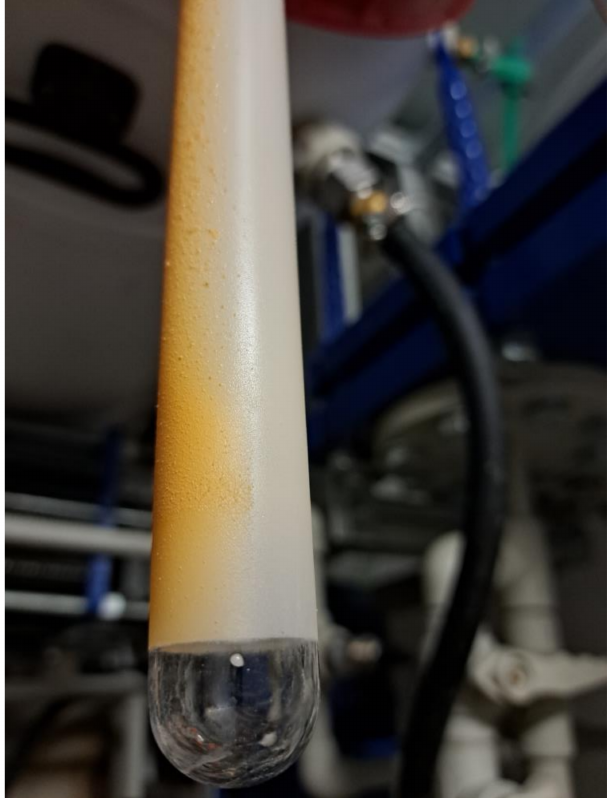
Figure 13. UV lamp with visible calcium incrustation. The rusty side was turned towards the bottom of the housing, i.e., towards the sediment in the horizontally placed